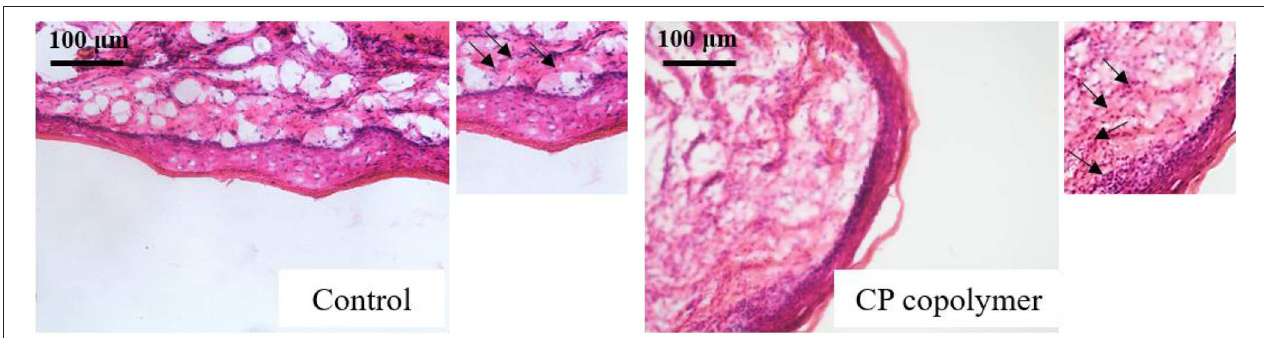
FIGURE 7 | Hematoxylin & eosin staining of excised oral gingival ulcer tissue sections from Wistar rats after treatment with the control (PBS) or CP copolymer for 10 days. (The black arrows represent fibroblasts).